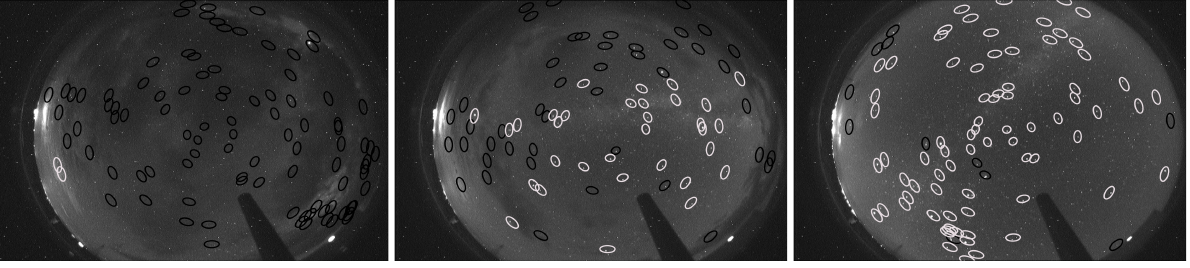
(b) Picture of 2 ⃝ in Fig. 9(06:24(UTC)). Matched stars : 32 , Expected stars : 77.